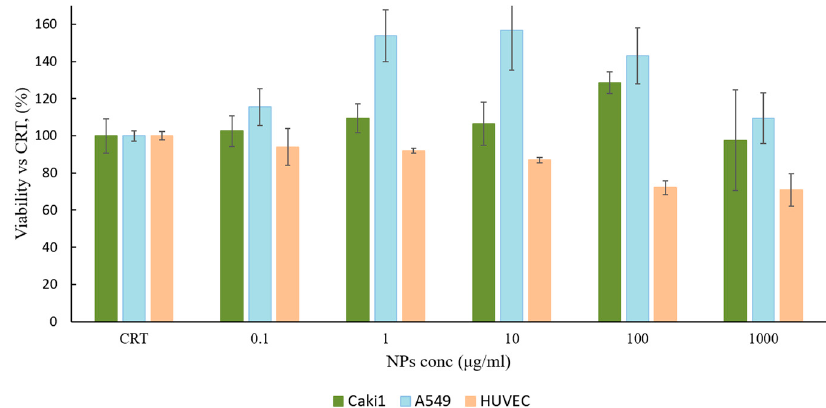
Figure 3. MTS proliferation assay performed on GE11-PLGA/PEG-PLGA blend NPs incubated for 48 h with Caki1, A549 and HUVEC cell lines. The data represent the mean ± sd ( n = 3, independent experiment). The results are expressed as viability percentage compared to untreated cells (CRT).